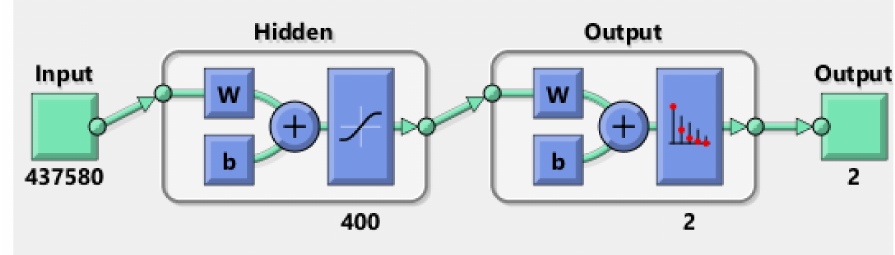
Figure 14. Neural Network architecture for ISIC 2019